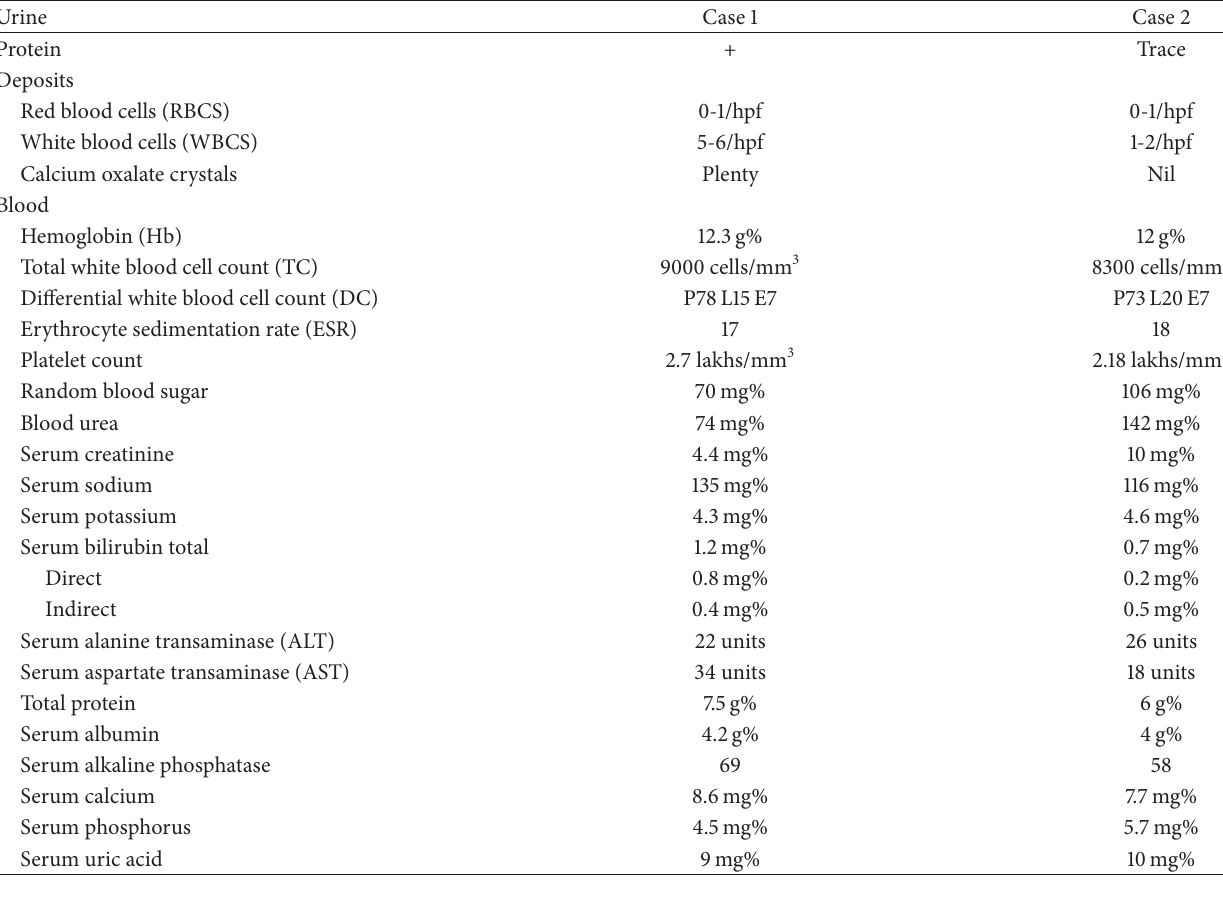
Table 1: Laboratory investigations at admission to hospital.